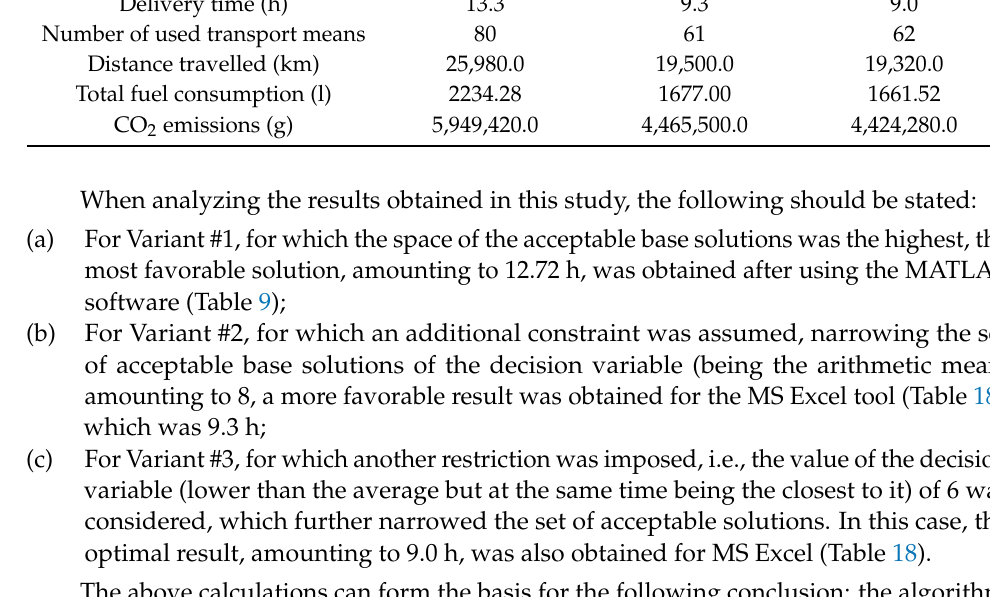
Variant #1 Variant